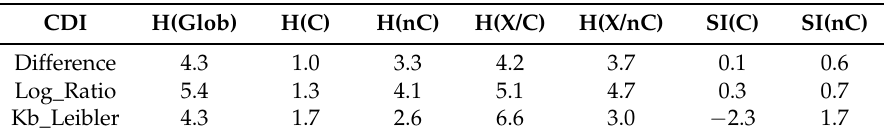
Table 1. DS1, CDI Information (metrics) Values.